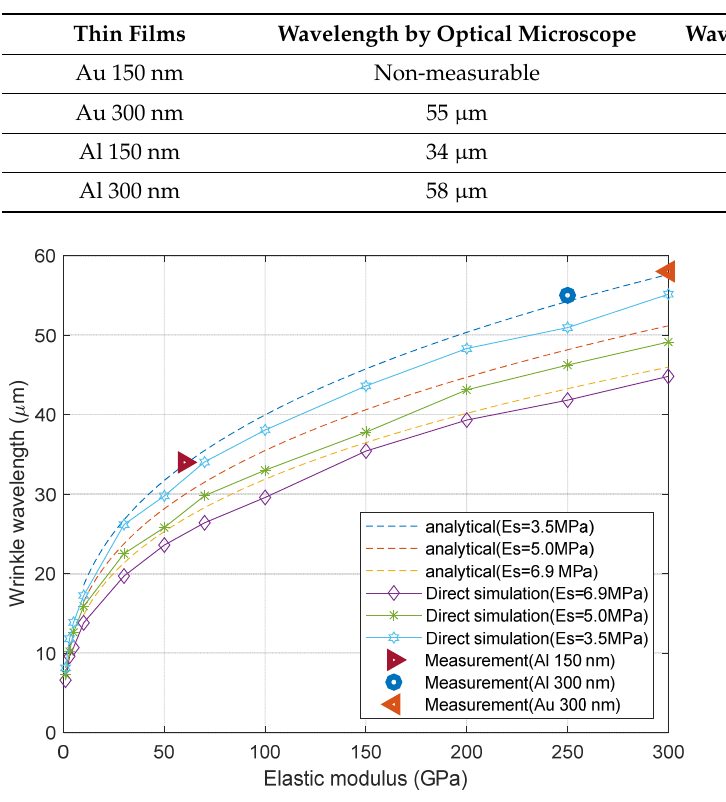
Table 1. Wavelength of the wrinkling metal pattern.